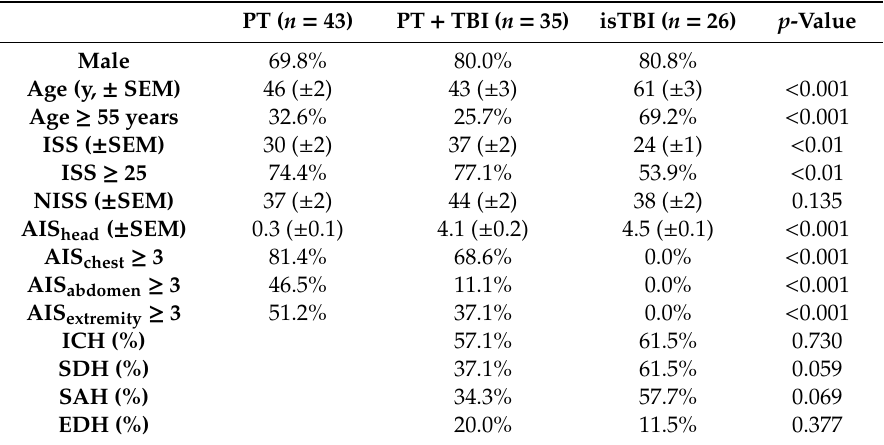
Table 1. Demographic and clinical injury characteristics stratified by injury pattern.